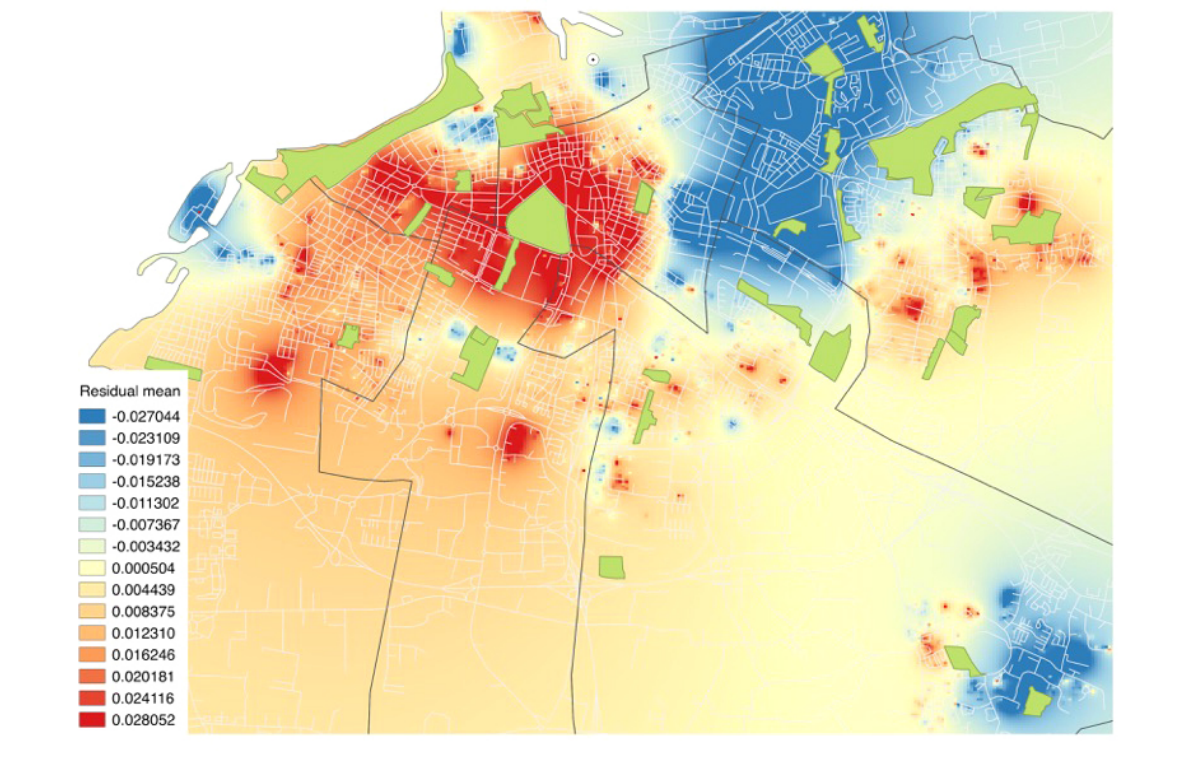
Fig. 3 . Malmö heat map based on residual from regression excluding only distance to closest park and park size from the regression. Red (blue) areas indicate that properties in that region typically sell at a relatively higher (lower) price. The legend indicates the magnitude of the difference. Taking the exponential of these values we get the percentage relative difference in selling price for the different